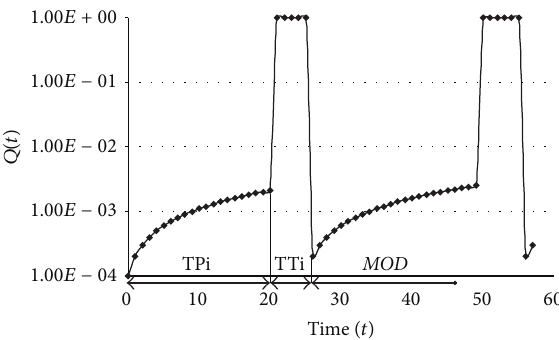
Figure 1: Component time dependent failure